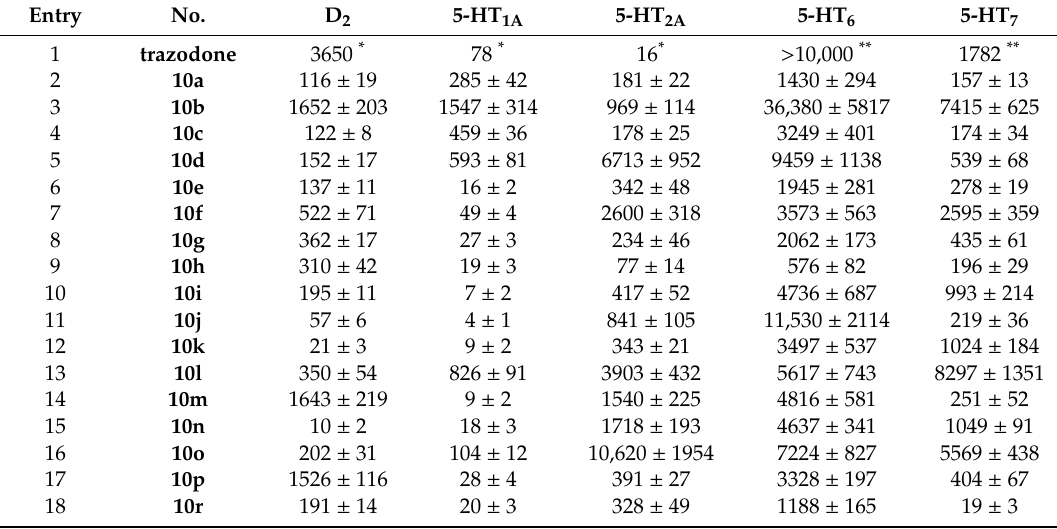
Table 6. Activity in Ki ± SD (nM) in vitro tests of trazodone derivatives 10a – 10k